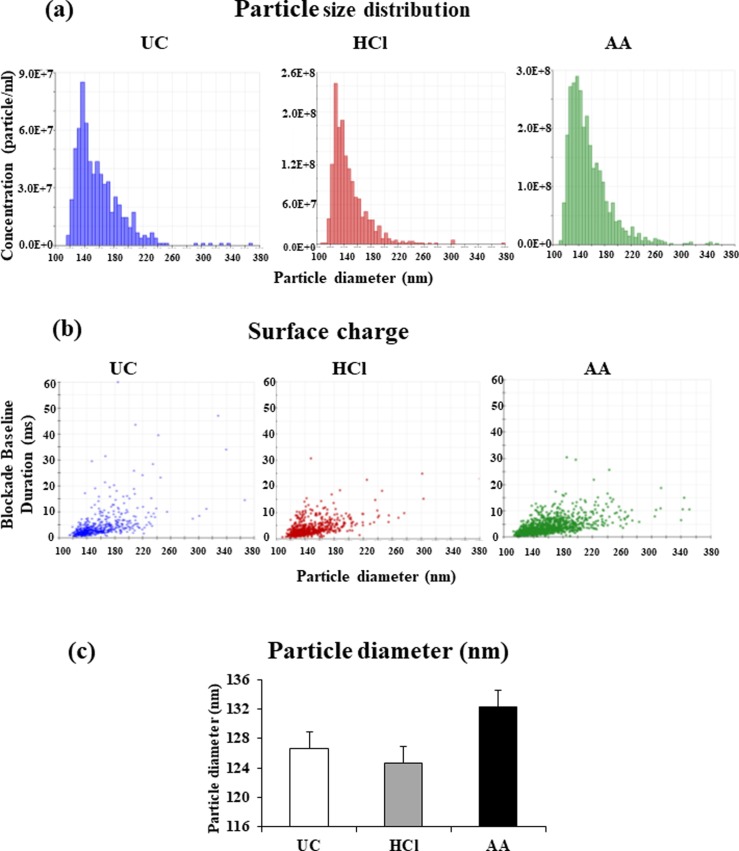
Particle size distribution and particle diameter.Comparison of the particle diameter of EVs in whey isolated by UC method, HCl-, or AA-treatments. Representative data from cow #1 were shown. (a) Particle size distribution and (b) surface charge were measured by TRPS. (c) Data from three independent experiments are represented as the mean ± standard deviation. Particle size did not differ significantly between the three methods (p>0.05).